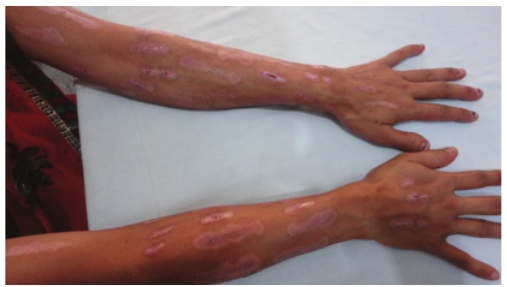
Figure 3: Confluent dermatitis artefacta lesions on the upper and lower limbs.